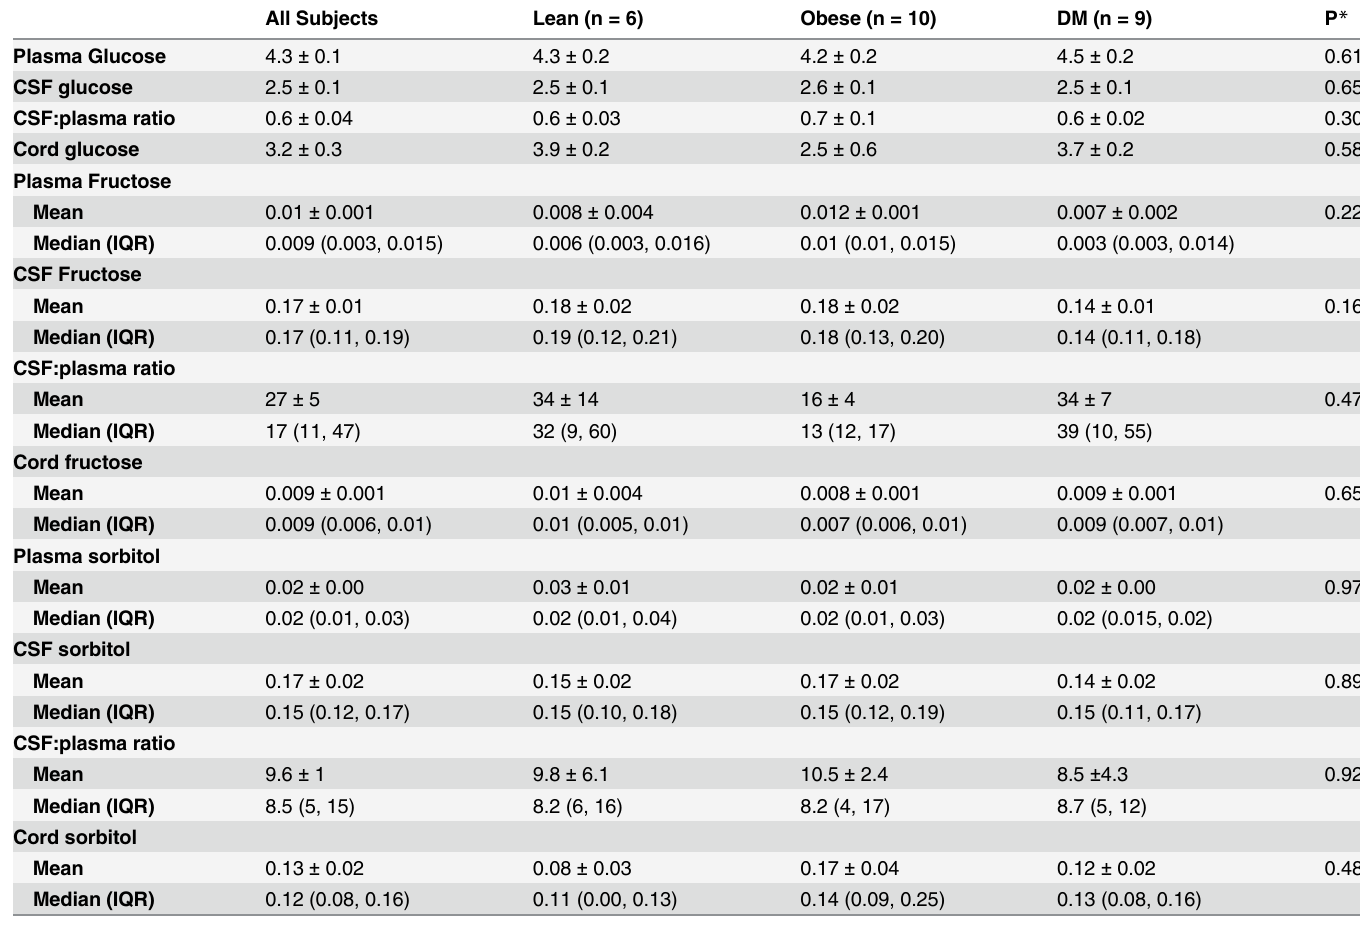
Table 2. Glucose, fructose and sorbitol levels for all